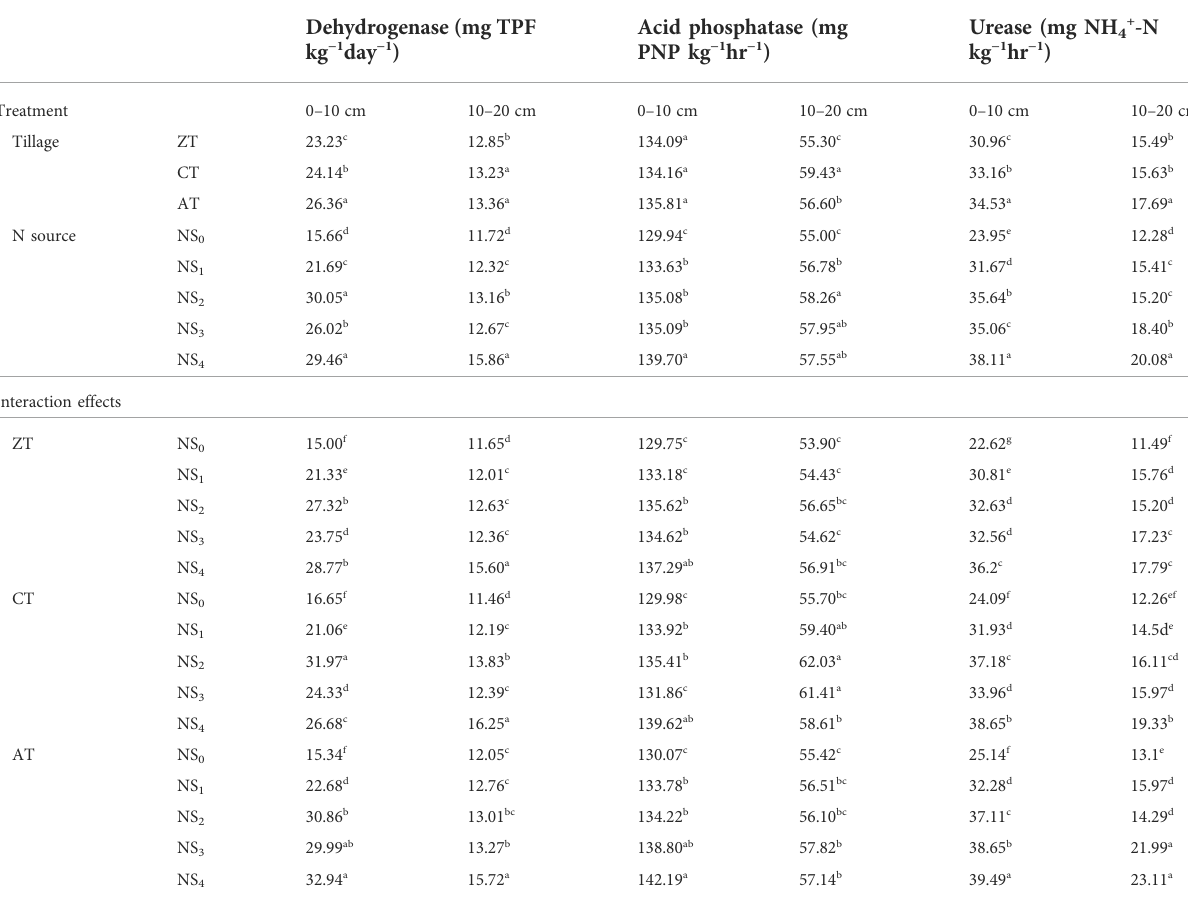
TABLE 5 Effects of tillage practices and N sources on the status of enzymatic activity ( viz. dehydrogenase activity, mg TPF kg − 1 · day − 1 ; acid- phosphatase, mg PNP kg − 1 · h − 1 ; urease, mg NH 4 -N kg − 1 · h − 1 ) in soil at the end of the experiment. Main and Sub-plots